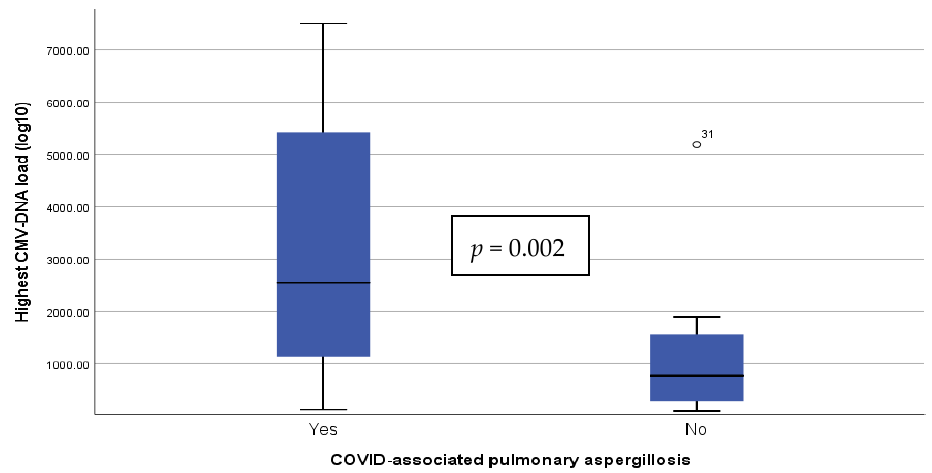
Figure 1. Peak CMV-DNA viral load among patients with CMV replication according to the diagnosis of pulmonary aspergillosis. Viral load is expressed in UI/mL (0.91 UI/mL equals 1 copy/mL). and represented in a linear scale. CMV: cytomegalovirus. Table 2. Multivariate analysis of factors associated with COVID-associated pulmonary aspergillosis.